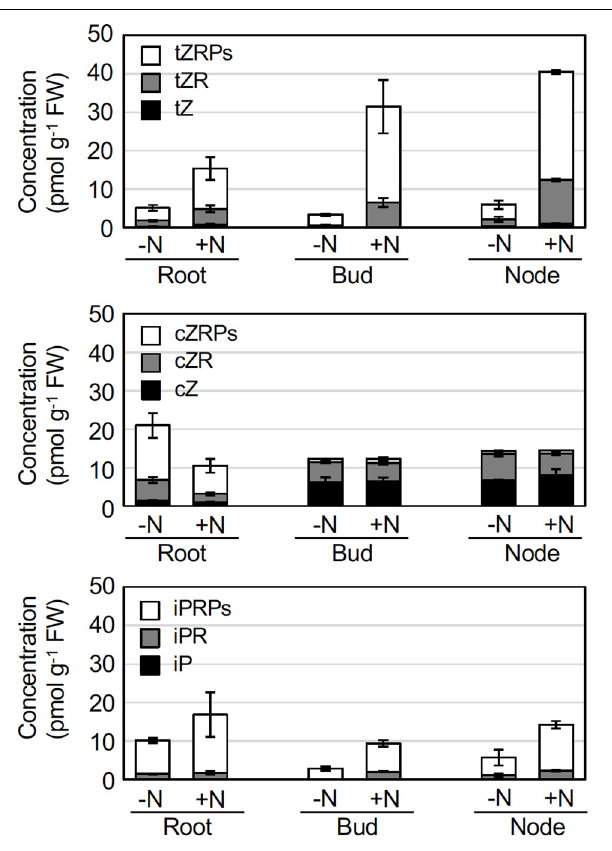
FIGURE 2 | Effects of nitrogen applications on cytokinin concentrations in rhizome roots, buds, and nodes. Young ramets having rhizomes at a similar growth stage were hydroponically grown in a low-N (200 µ M NH 4 NO 3 ) medium for 2 weeks. The ramets were subsequently transferred to culture media containing no nitrogen (-N) or 2 mM NH 4 NO 3 (+N). 6 h after transfer, rhizome roots, buds, and nodes were separately harvested, and the cytokinin hormone content was analyzed. Data are presented as the mean ± S.E. ( n = 3). The complete data set is presented in Supplementary Table 1 . tZ, trans -zeatin; tZR, tZ riboside; tZRPs, tZR 5’-phosphates; cZ, cis -zeatin; cZR, cZ riboside; cZRPs, cZR 5’-phosphates; iP, N 6 -( (cid:49) 2 -isopentenyl)adenine;